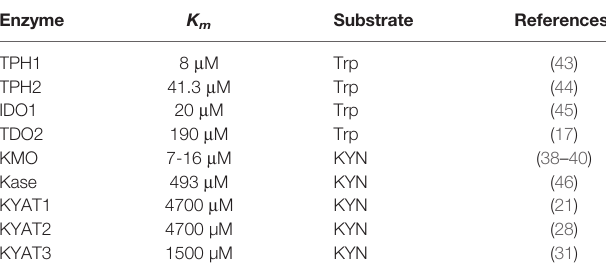
TABLE 1 | The characteristics of enzyme related to KYNA metabolism. Enzyme K m